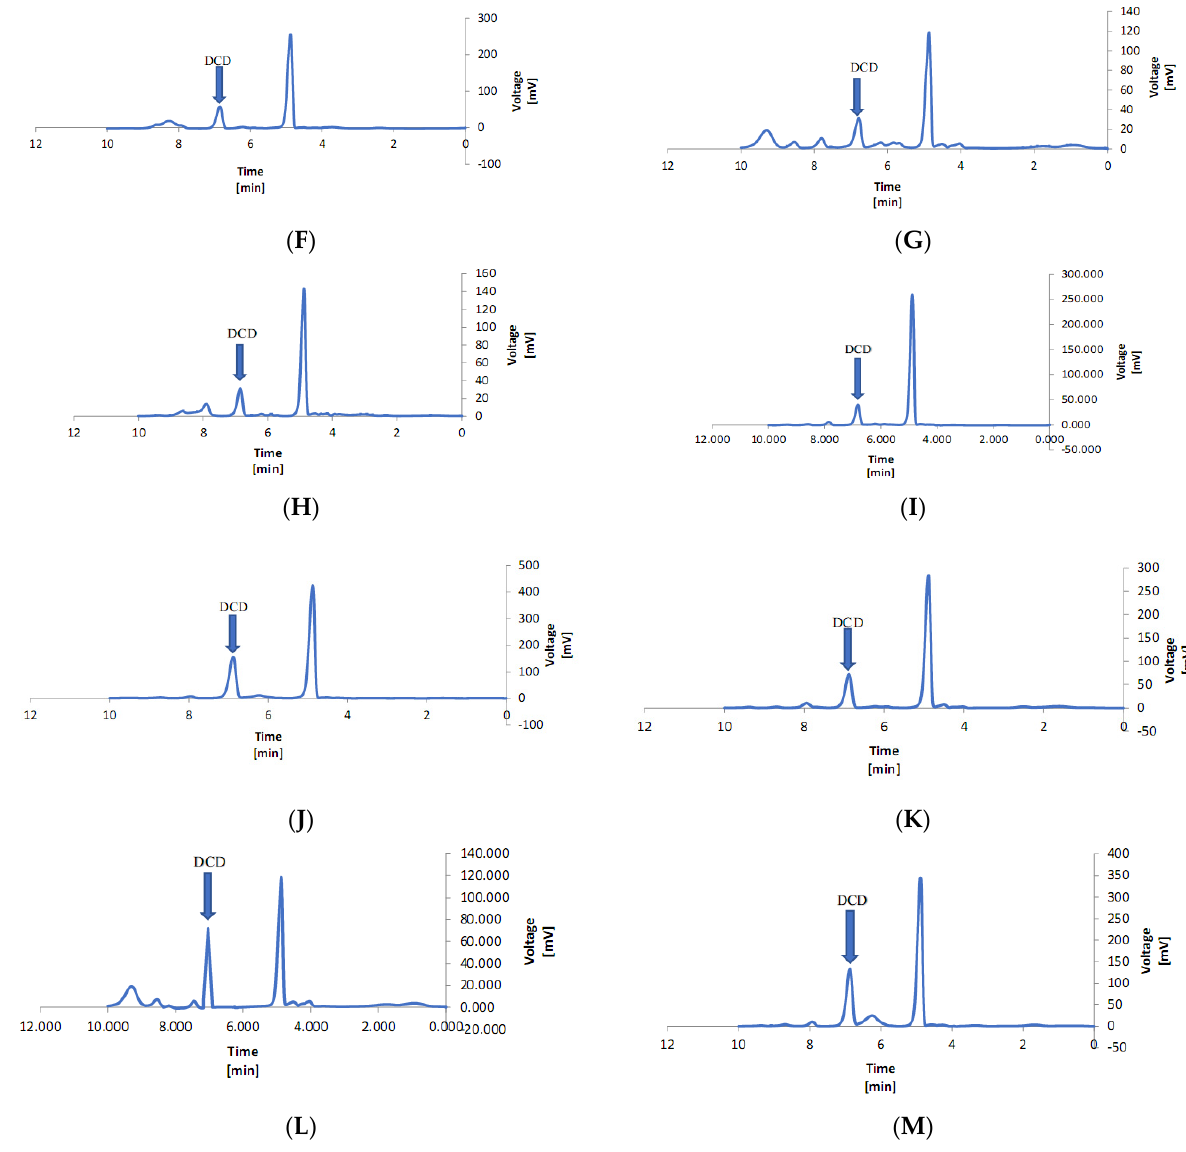
Figure 8. Effect of Piriformospora indica, Glomus etunicatum , and Glomus mosseae on dicyandiamide content in Lettuce leaves. ( A ) Standard chart of the dicyandiamide, ( B ) 5 mg kg − 1 of dicyandiamide, ( C ) Piriformospora indica + 5 mg kg − 1 of dicyandiamide, ( D ) Glomus etunicatum + 5 mg kg − 1 , ( E ) Glomus mosseae + 5 mg kg − 1 of dicyandiamide, ( F ) 50 mg kg − 1 of dicyandiamide, ( G ) Piriformospora indica + 50 mg kg − 1 of dicyandiamide, ( H ) Glomus etunicatum + 50 mg kg − 1 of dicyandiamide, ( I ) Glomus mosseae + 50 mg kg − 1 of dicyandiamide, ( J ) 100 mg kg − 1 of dicyandiamide, ( K ) Piriformospora indica + 100 mg kg − 1 of dicyandiamide, ( L ) Glomus etunicatum + 100 mg kg − 1 of dicyandiamide, and ( M ) Glomus mosseae + 100 mg kg − 1 of dicyandiamide.